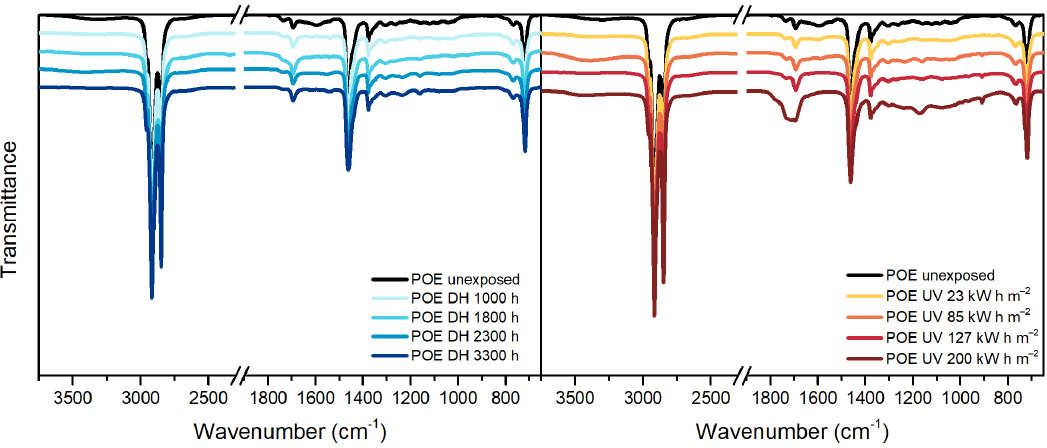
Figure 6. FT-IR ATR Spectroscopy measurements of POE samples before and after exposure to DH (left) and UV test (right).